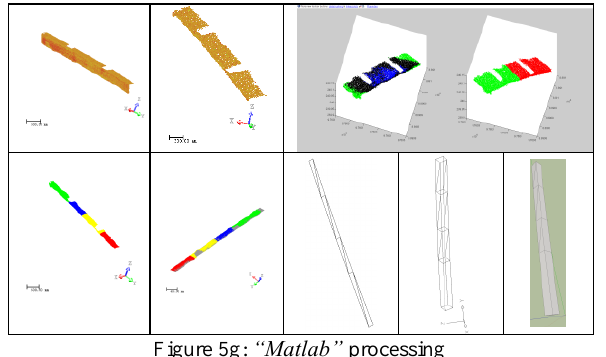
Figure 5g: “Matlab”